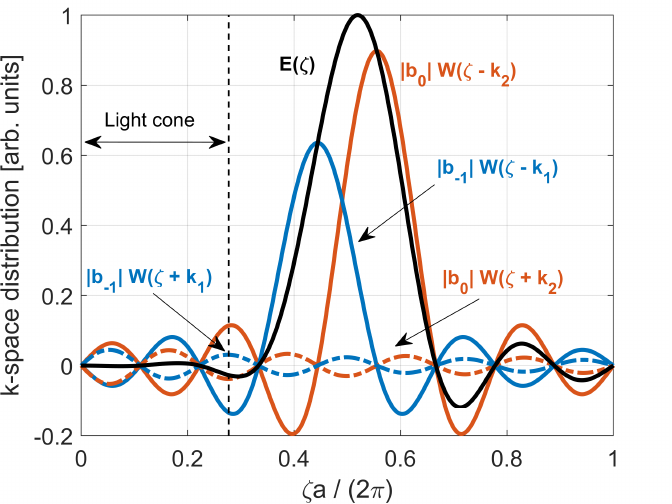
Figure 10. Components of the k -space distribution for an L9 cavity computed by Equation (19). The blue (red) solid line is for the sinc function centered at + k 1 ( + k 2 ). The blue (red) dotted line corresponds to the sinc function centered at − k 1 ( − k 2 ). The black solid line is the total spectrum. The black dashed line delimits the light